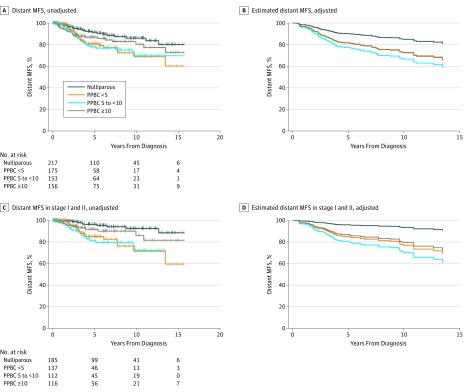
Risk for Metastasis in Young Women From the Colorado Young Women's Breast Cancer CohortA, Unadjusted distant metastasis–free survival (MFS) (log rank test, P = .02) (eTable 1 in the Supplement). B, Distant MFS adjusted for stage, age, year of diagnosis, and tumor biological subtype. C, Unadjusted distant MFS in women with stage I or II cancer. D, Distant MFS in women with stage I or II cancer adjusted for age, year of diagnosis, and tumor biological subtype. PPBC <5 indicates postpartum breast cancer (PPBC) within 5 years of parturition; PPBC 5 to <10, PPBC within 5 to less than 10 years after parturition; and PPBC ≥10, PPBC after 10 or more years after parturition. Panels B and D show estimated values from adjusted Cox proportional hazards regression models; thus, including the number at risk is not appropriate.